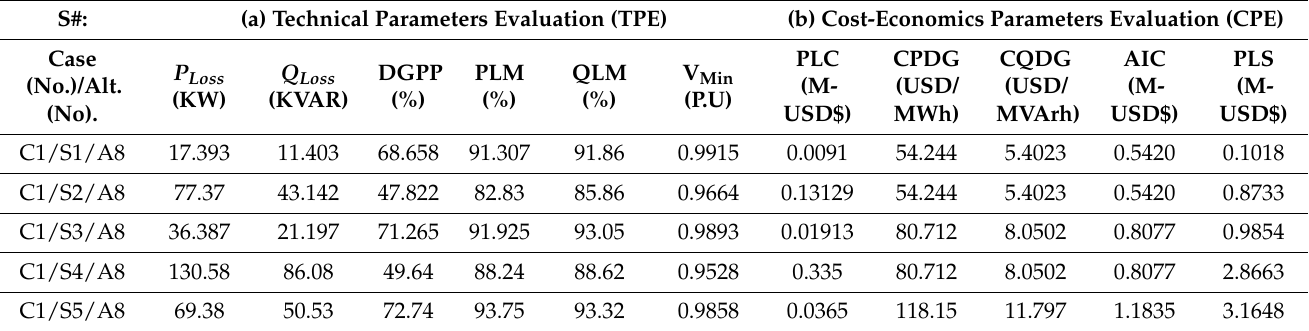
Table 8. Techno-economic (TPE/CPE) evaluations in C1/S1–S5 for the 33-bus MDN.